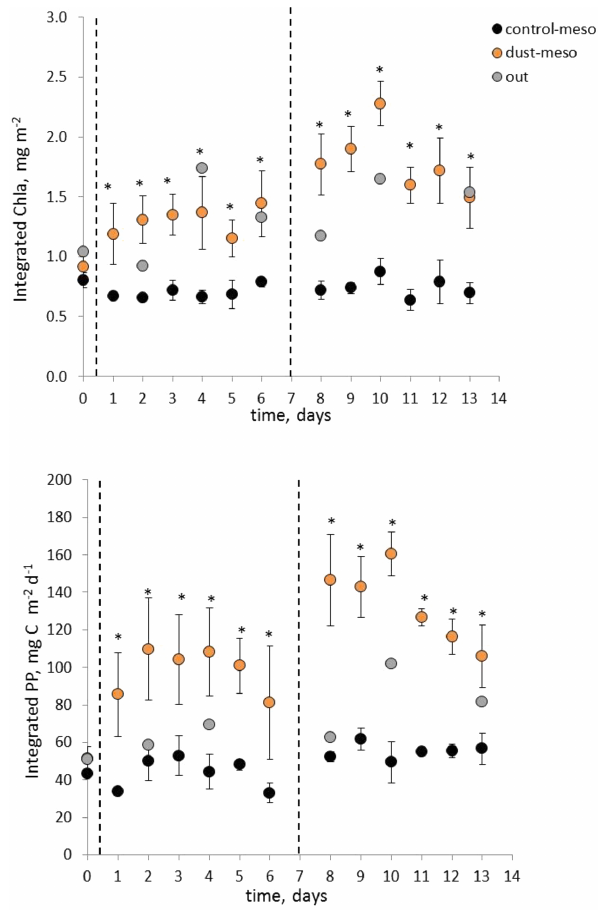
Figure 4. Mean integrated chlorophyll a (Chl a) in mgm − 2 (top panel) and mean integrated primary production (PP) in mgCm − 2 d − 1 (bottom panel) over mesocosms during the DUNE-2-R1 and DUNE-2-R2 experiments in the Control-meso (black dot), Dust- meso (orange dot) and out (grey dot). The dotted lines represent the time of the dust seedings. Data in the Control-meso and Dust-meso represent the average and standard deviations of the three replicate mesocosms. Means in the Dust-meso that were significantly differ- ent from the Control-meso ( p < 0 . 05) are labeled with the * sym- bol.